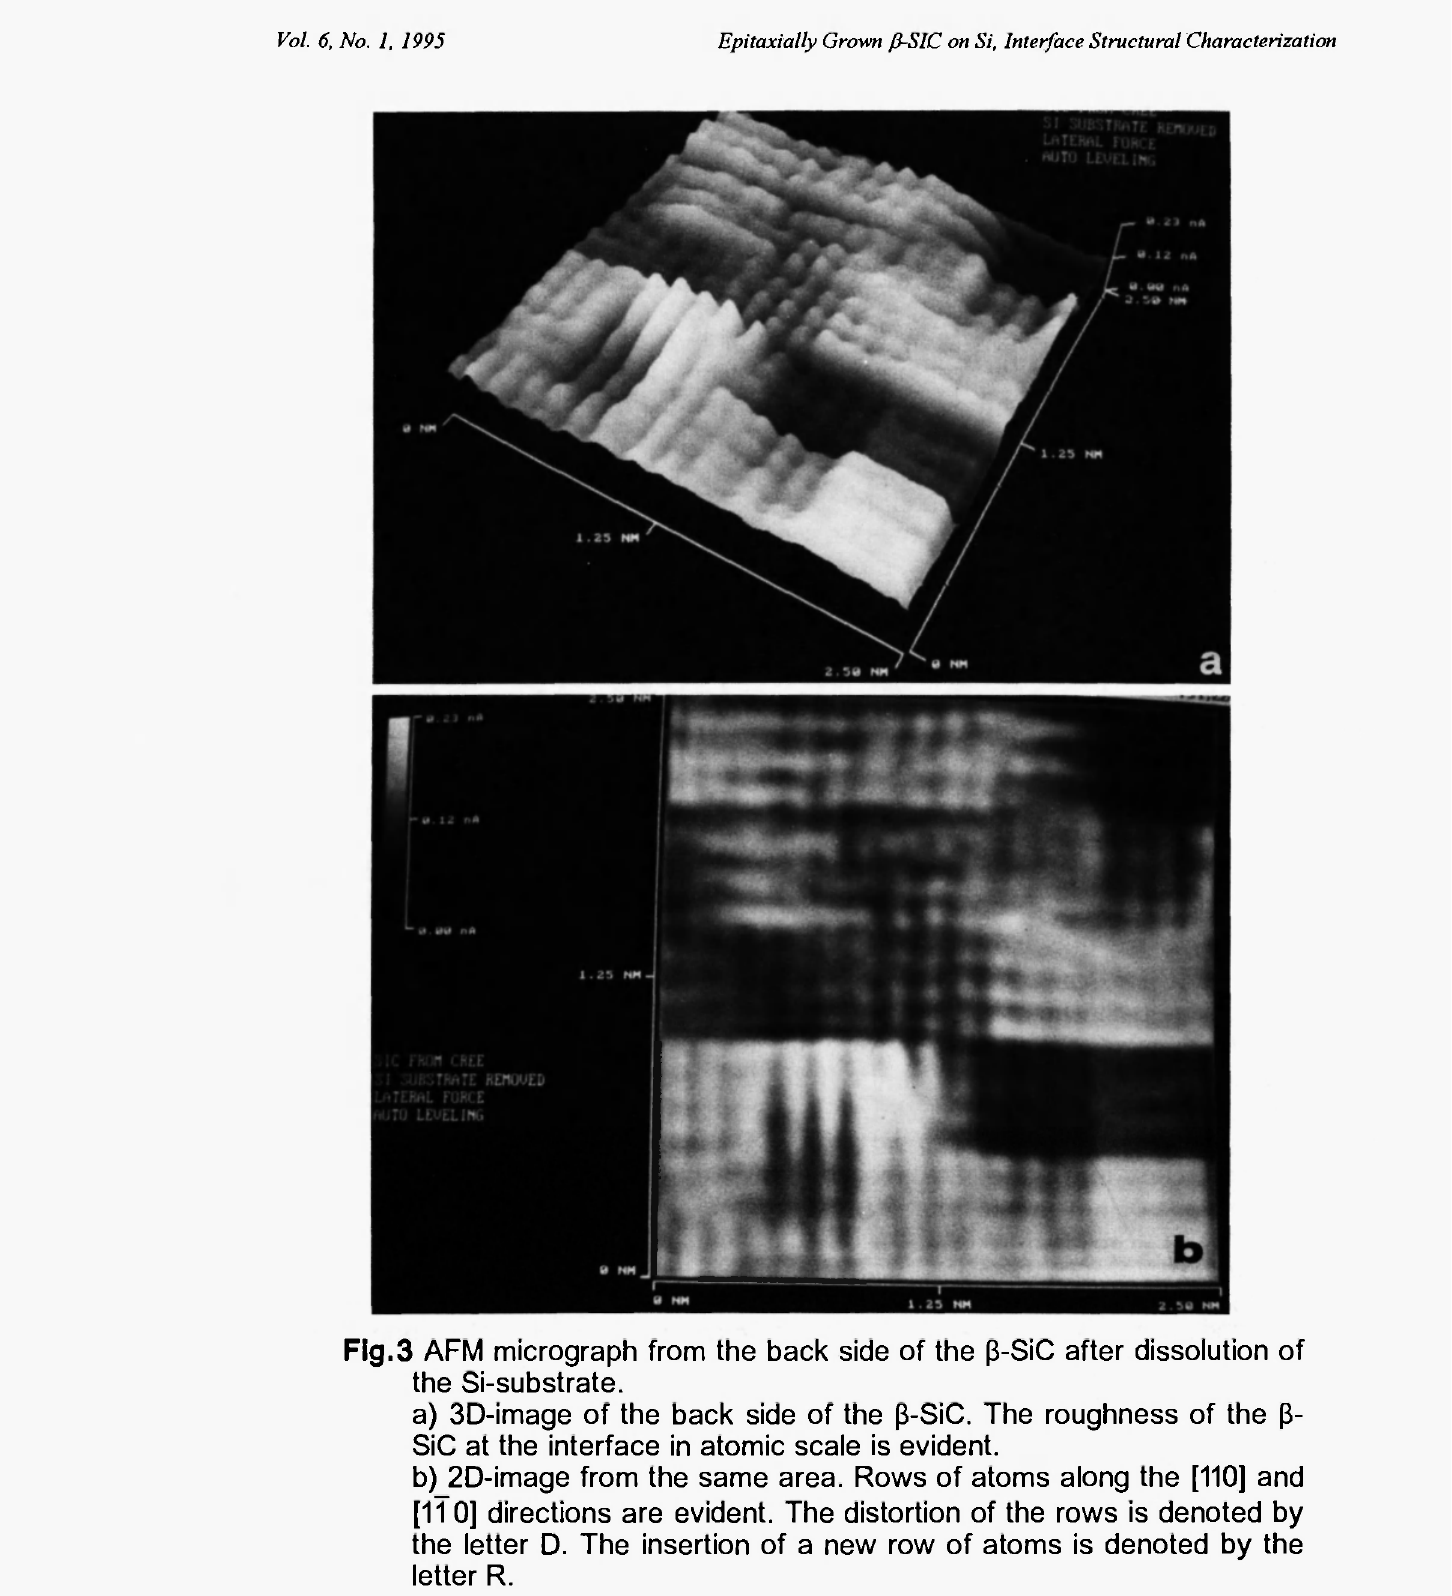
Fig.3 AFM micrograph from the back side of the ß-SiC after dissolution of the